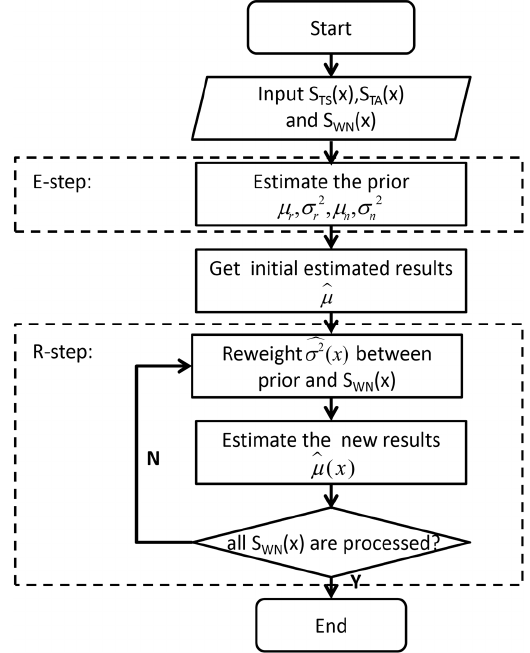
Figure 2. Iteration Bayesian reweighed (IBR) algorithm process. Sensors 2020 , 20 , x FOR PEER REVIEW